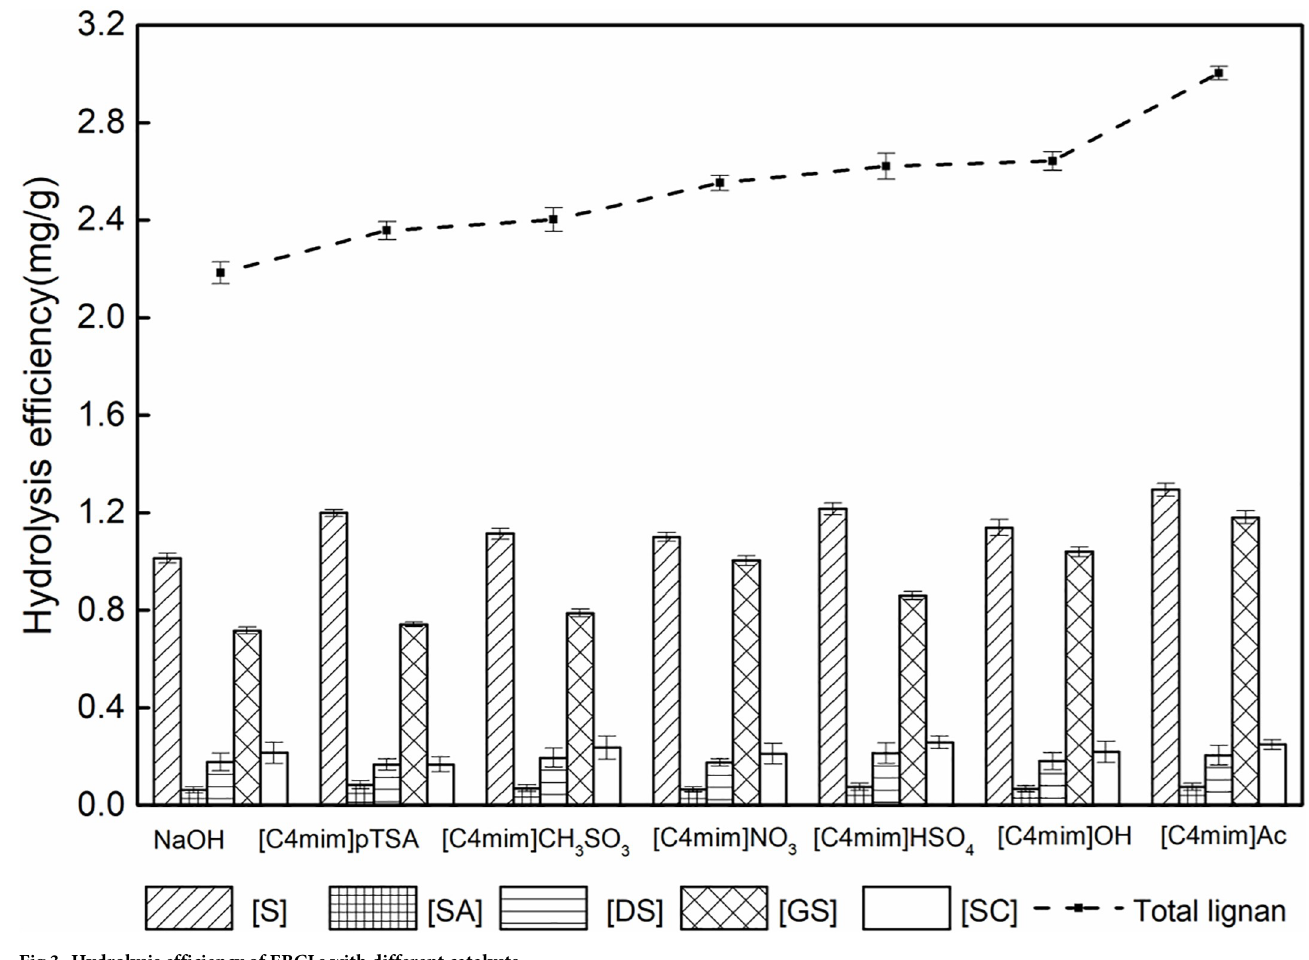
Fig 3. Hydrolysis efficiency of EBCLs with different catalysts.